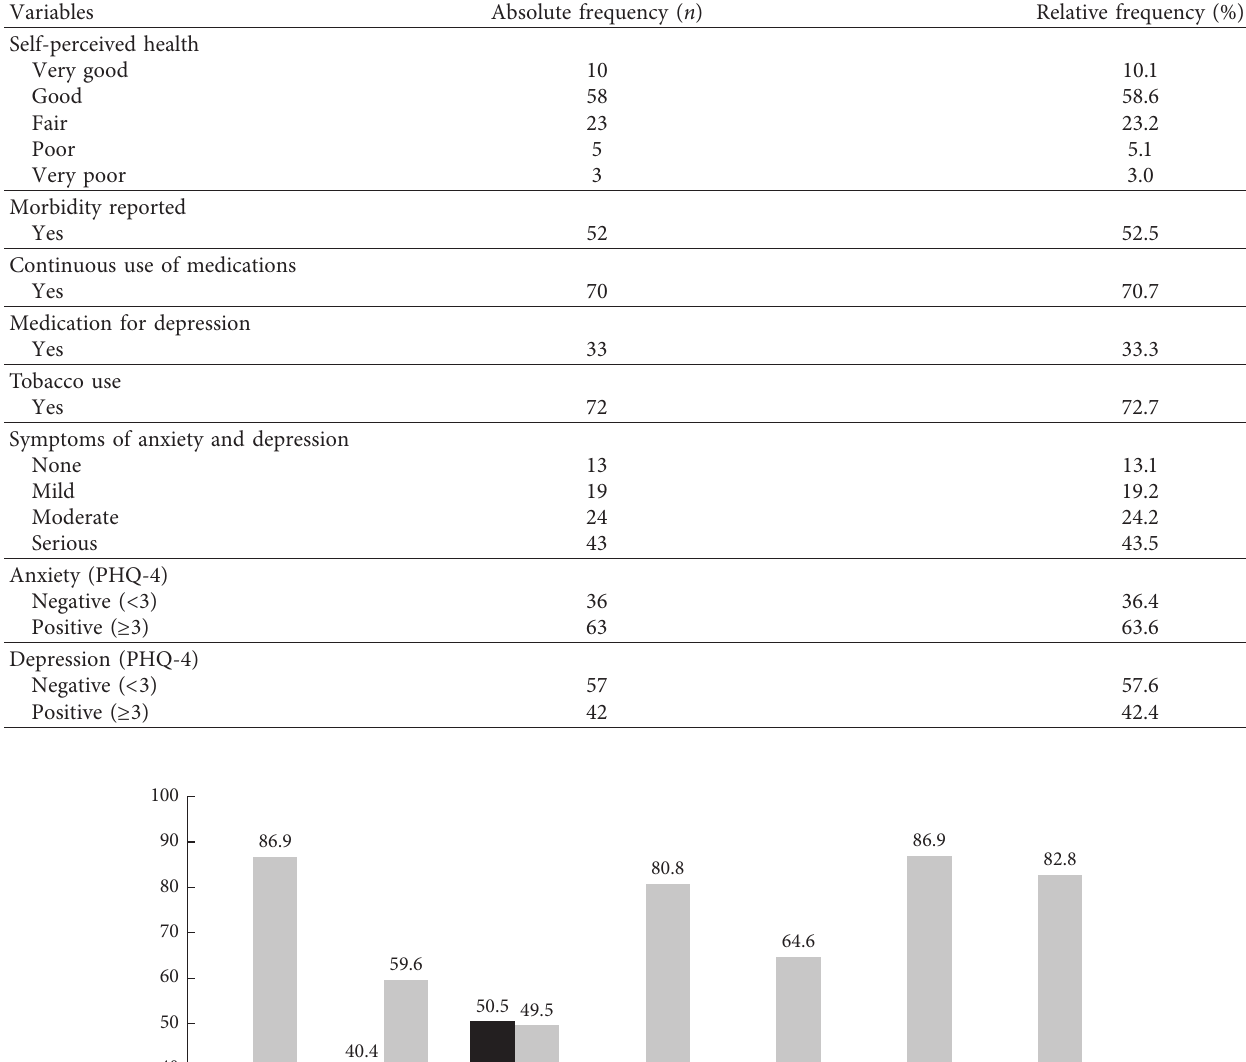
Table 3: Characterization of women inmates in Juiz de Fora, according to self-perceived health and morbidity reported, Juiz de Fora, 2020. Variables